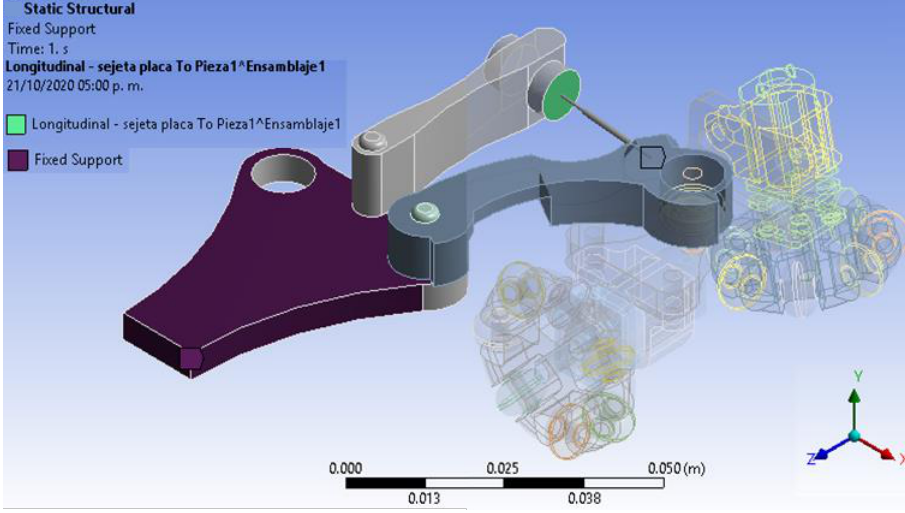
Figure 9. Boundary conditions, fixed